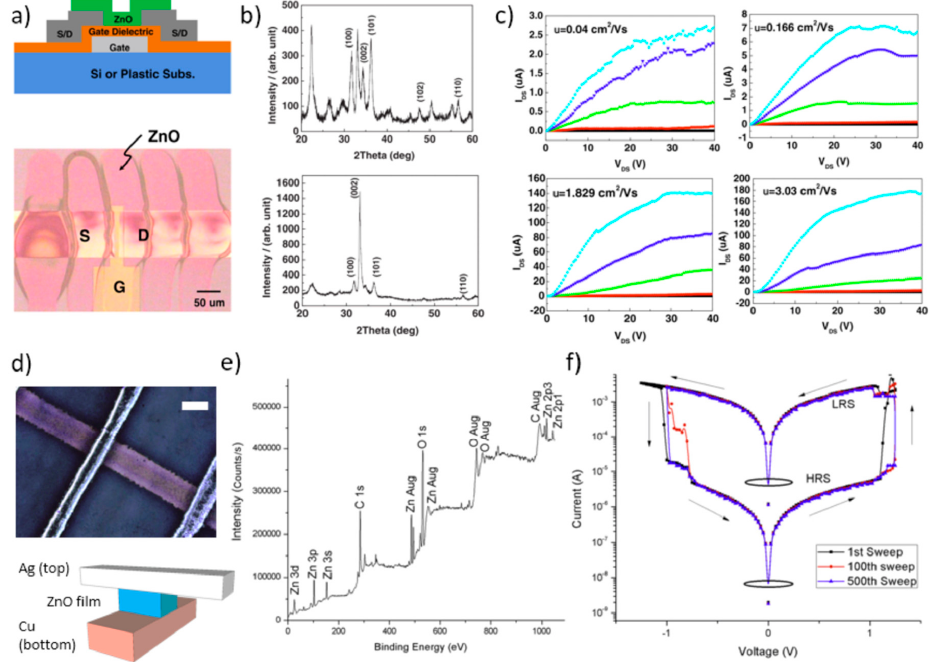
Figure 17. Applications in electronic devices. ( a ) Bottom-gate architecture of an inkjet printed ZnO nanorod based thin-film transistor (TFT, upper panel), and optical micrograph of the device top-view. ( b ) XRD patterns of the inkjet printed ZnO film, RT-dried (upper panel) and after annealing at 150 ◦ C for 1 h in oxygen. ( c ) Drain current – drain voltage characteristics of the ZnO nanorod based TFT dried for 10 and 60 min (upper panels, left and right, respectively), and annealed at 150 ◦ C for 10 and 60 min (lower panels, left and right, respectively). Reproduced from Reference [139] Copyright (2014) The Japan Society of Applied Physics. ( d ) All inkjet printed ZnO NP based memristor device: optical microscopy image of one memristive pixel (upper panel, scale bar 100 µ m), and schematic representation added to illustrate device elements (lower panel). ( e ) X-ray photoelectron spectroscopy (XPS) analysis of a printed ZnO NP film. ( f ) Semi-log plot of current-voltage sweeps (1st, 100th, and 500th sweeps) from one of the 9 memristor pixels. The bistable memristive behavior with the resistive switching to the low-resistance state (LRS) and to the high-resistance state (HRS) is indicated (sweep direction is indicated by arrows). Reproduced from Reference [145]. Copyright (2013), with permission from